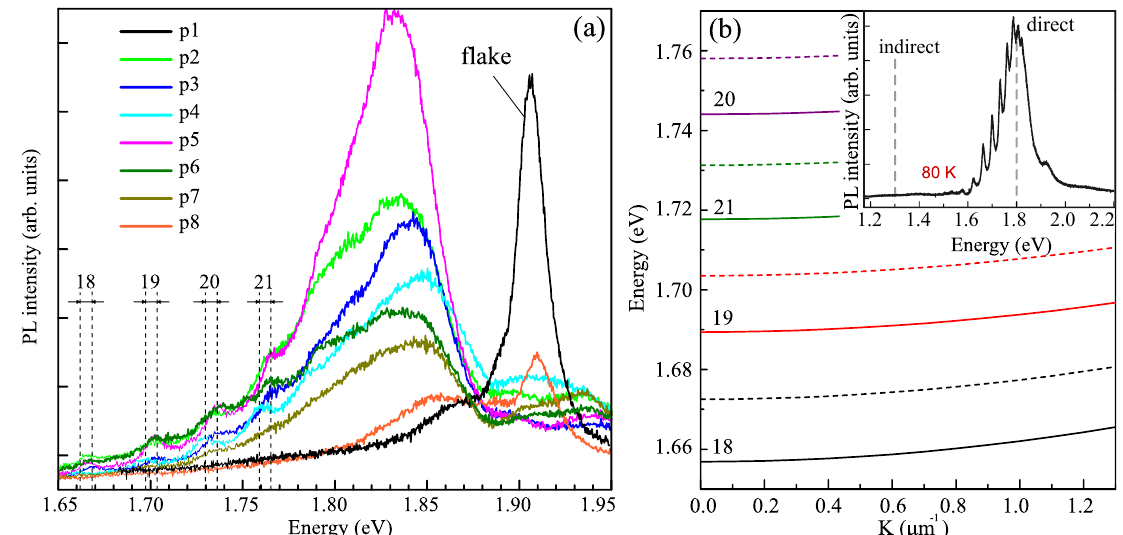
Figure 2. ( a ) Non-polarized micro-PL spectra measured at 10 K in the spectral range of direct exciton transitions from several spots of MoS 2 NT, indicated by green dots in Figure 1a. Black line is a spectrum taken from the planar MoS 2 layer (p1, flake). The dotted lines indicate the energies of optical modes with angular quantum numbers m = 18–21 calculated for the NT with the wall thickness varying by one monolayer. ( b ) Dependence of the energies of the optical modes with the angular numbers m = 18–21 on the wave vector K along the NT axis calculated for NTs with the 44-monolayer wall (dashed lines) and 46-monolayer wall (solid lines). The inset shows the TM-polarized micro-PL spectrum of the NT at 80